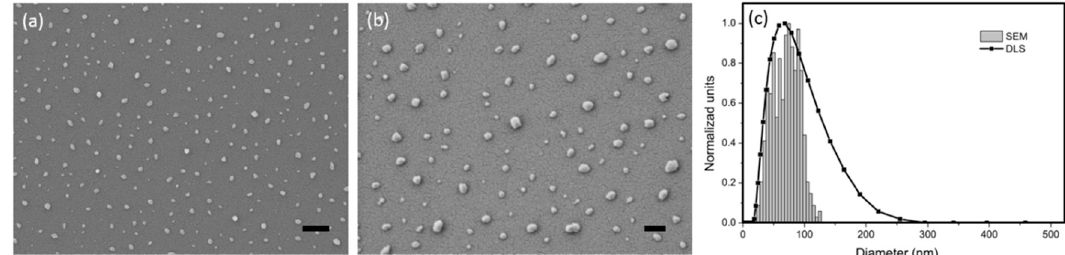
Figure 1. Characterization of CsWO 3 nanoparticle (NPs). ( a , b ) Scanning electron microscopy (SEM) images and ( c ) distribution profile of feature sizes of the NPs are illustrated. The scale bars shown on ( a ) and ( b ) are 500 nm and 200 nm, respectively.